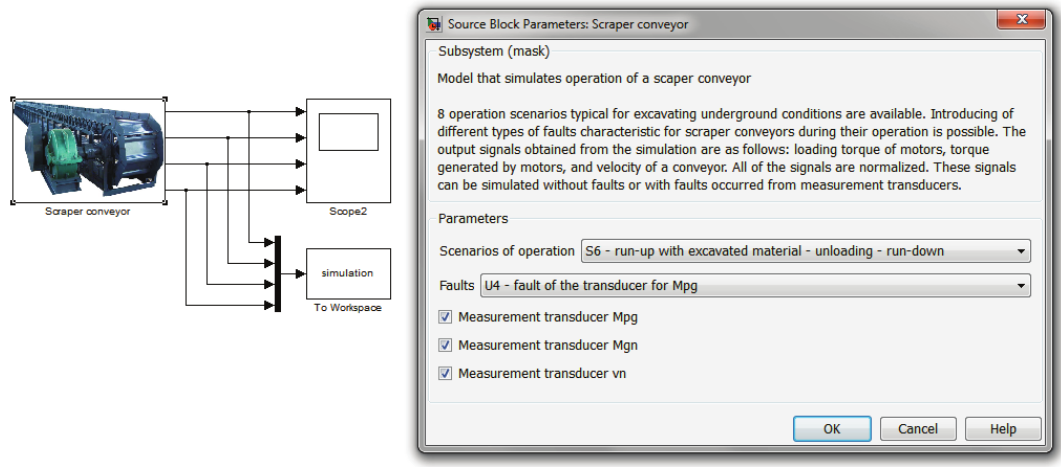
Fig. 4. The main block of the simulator of scraper conveyor and a parameterization window